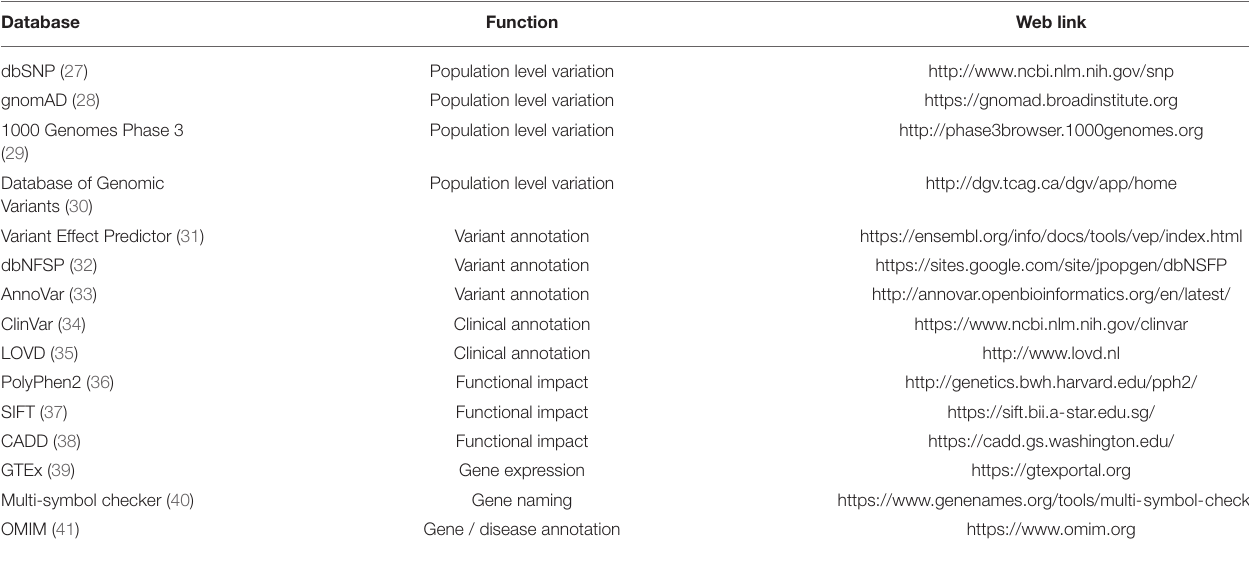
TABLE 1 | Resources for variant detection in precision medicine